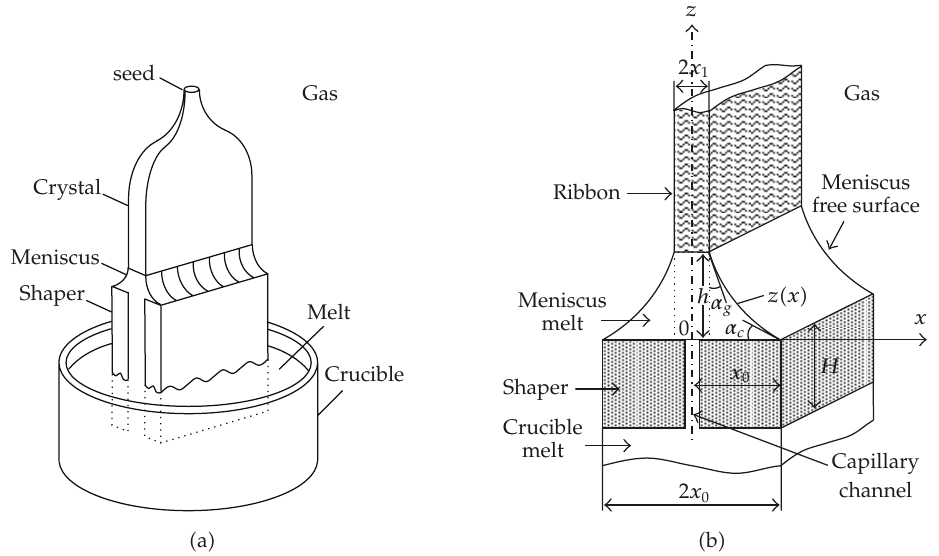
Figure 1: Meniscus geometry in the ribbon growth by EFG method. (cid:3) 3D representation.